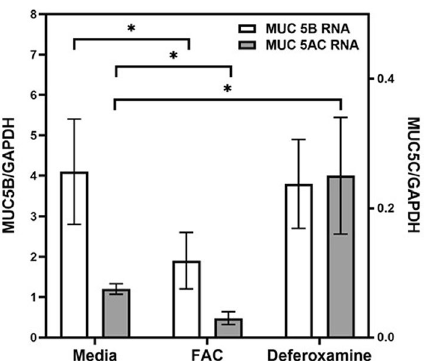
Figure 1. qPCR for MUC5B and MUC5C. RNA for MUC5B and MUC5AC was quantifiable in NHBE cells. After exposure to FAC, RNA for MUC5B and MUC5AC decreased while deferoxamine had the opposite effect for MUC5AC. *Increased or decreased relative to media (p < 0.05).